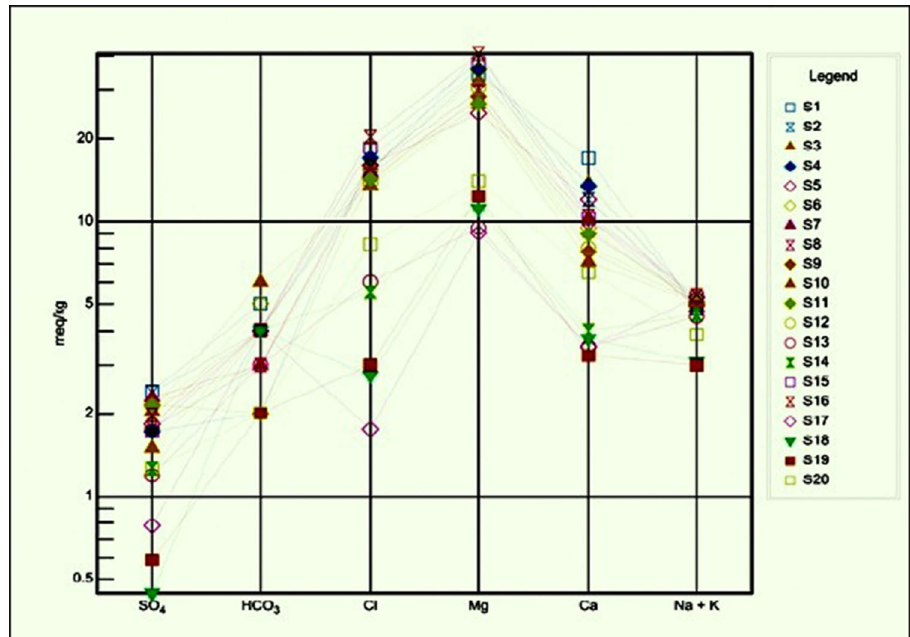
Fig. 7 Schoeller diagram of groundwater chemistry of the study